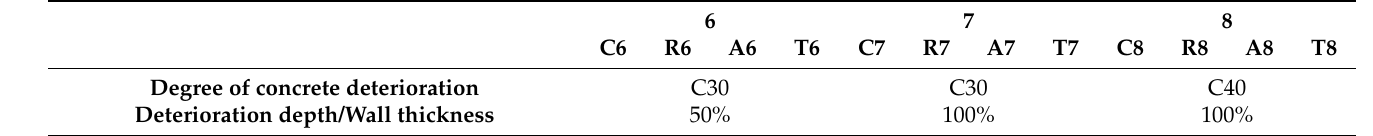
Table 2. Groups of concrete deteriorated cable tunnel modelling.